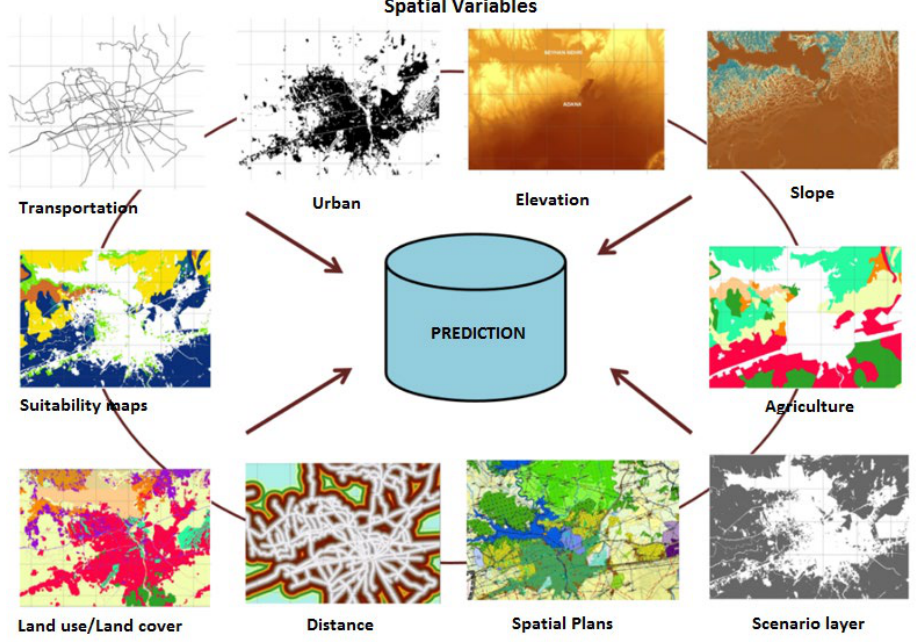
Figure 3 Urban growth modelling inputs for